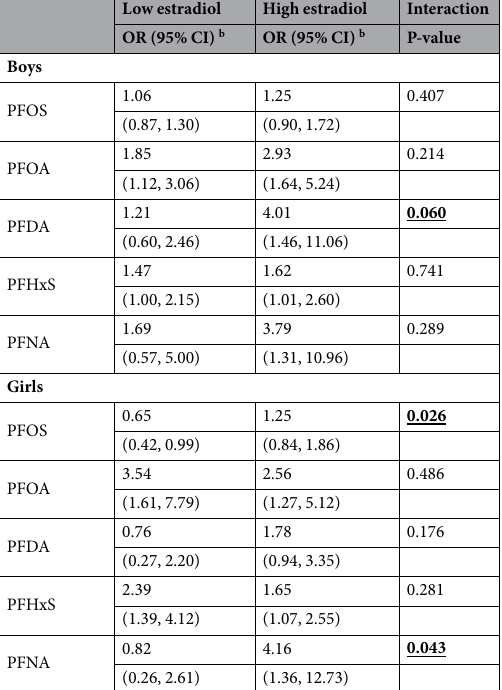
Table 4. Interaction effects of PFASs (ng/mL) and estradiol category on asthma, by sex ab . a low vs high grouped according to median estradiol level. b All models adjusted for age, sex, body mass index, parental education, environmental tobacco smoke exposure, physical activity, and month of